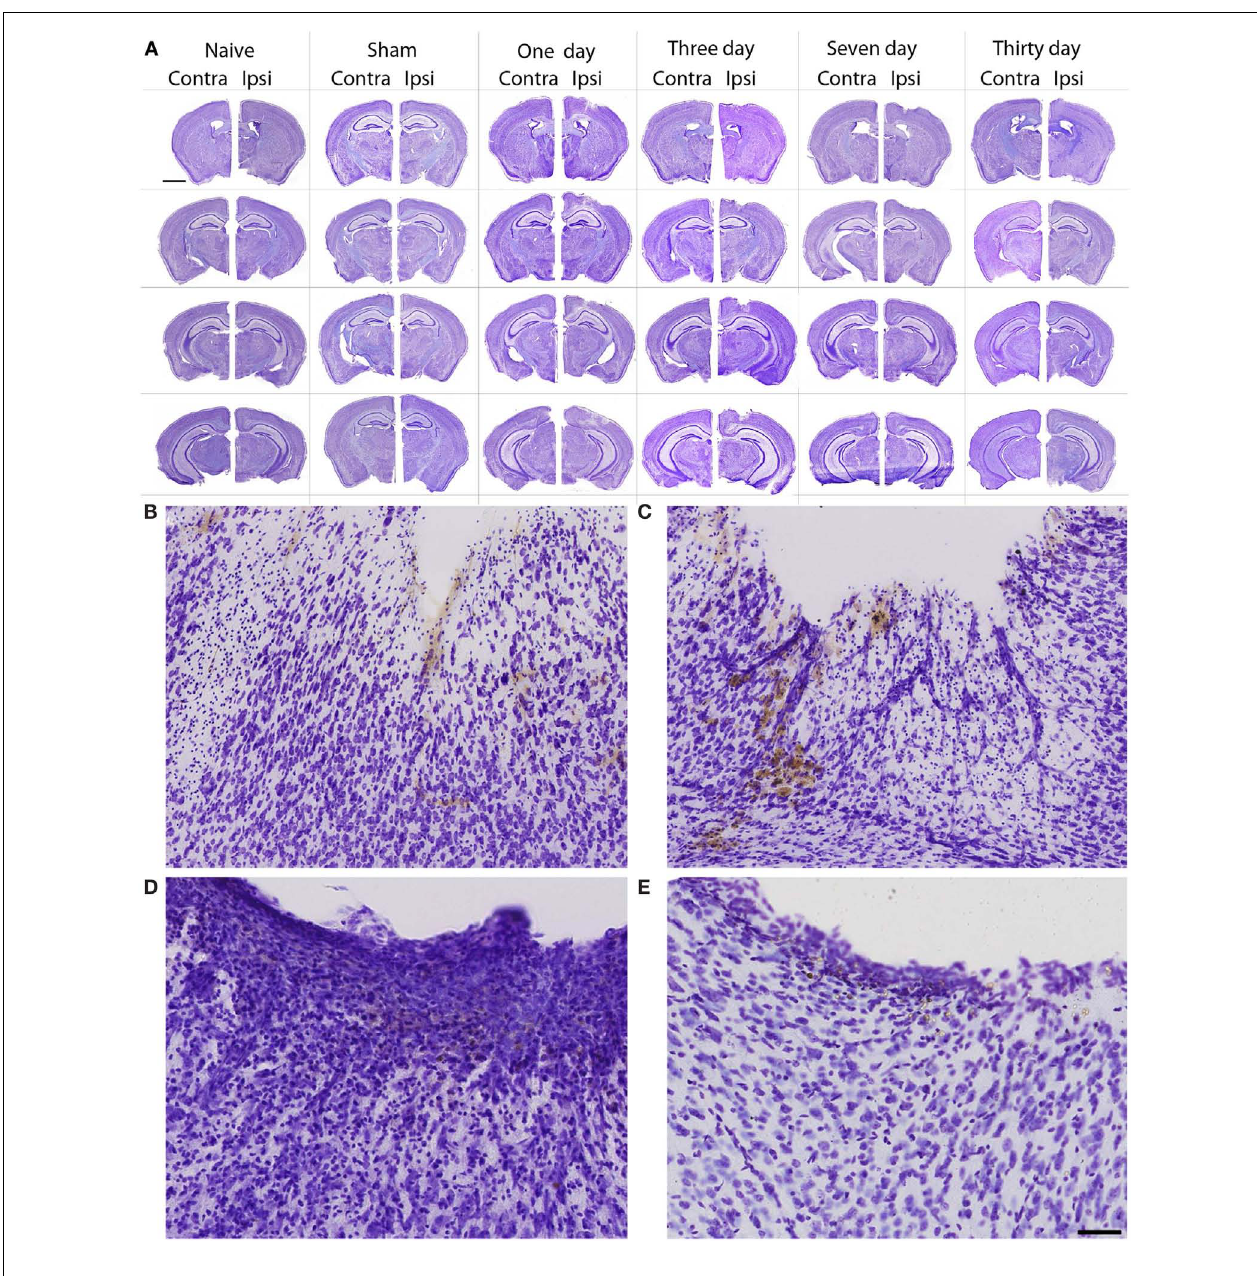
ingested by macrophages, the cells containing the brown staining are quite possibly macrophages. Note that the cortical layers subjacent to the lesion appear relatively intact at this timepoint. In (C) , the boxed area from the 3-day FPI mice is shown in enlargement. In (D) , the dark blue staining is likely indicative of pial repair. Note that the typical layering and columnar appearance of the cortex is altered. At 30days post-FPI (E) , the pial surface appears intact, but remnants of blood in the peri-lesion area remain. Note that the typical layering of the cortex remains altered at this timepoint. Scale bar in (A) = 2mm for all low magnification images and scale bar in in (E) = 80 µ m for (B–E) .